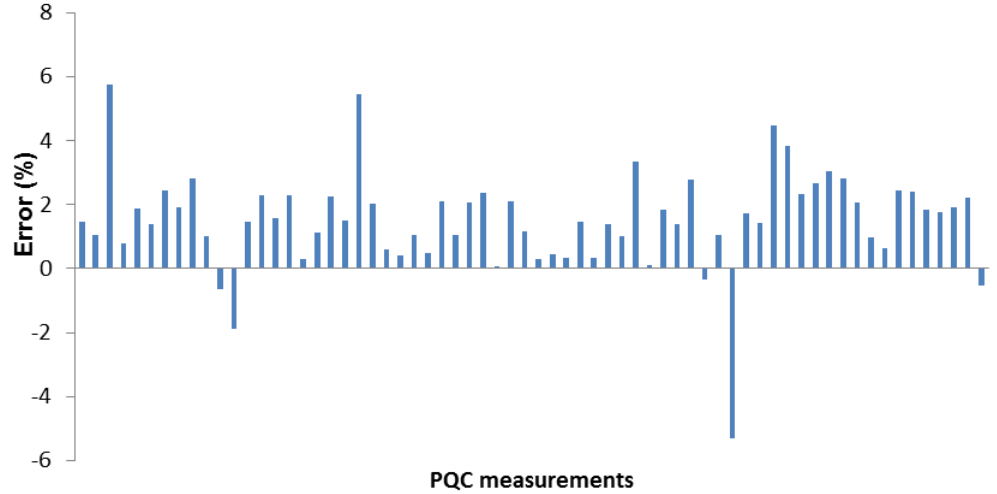
Figure 5. Frequency measurement errors (%) between the sensor array device and the EIP 578 instrument in laboratory